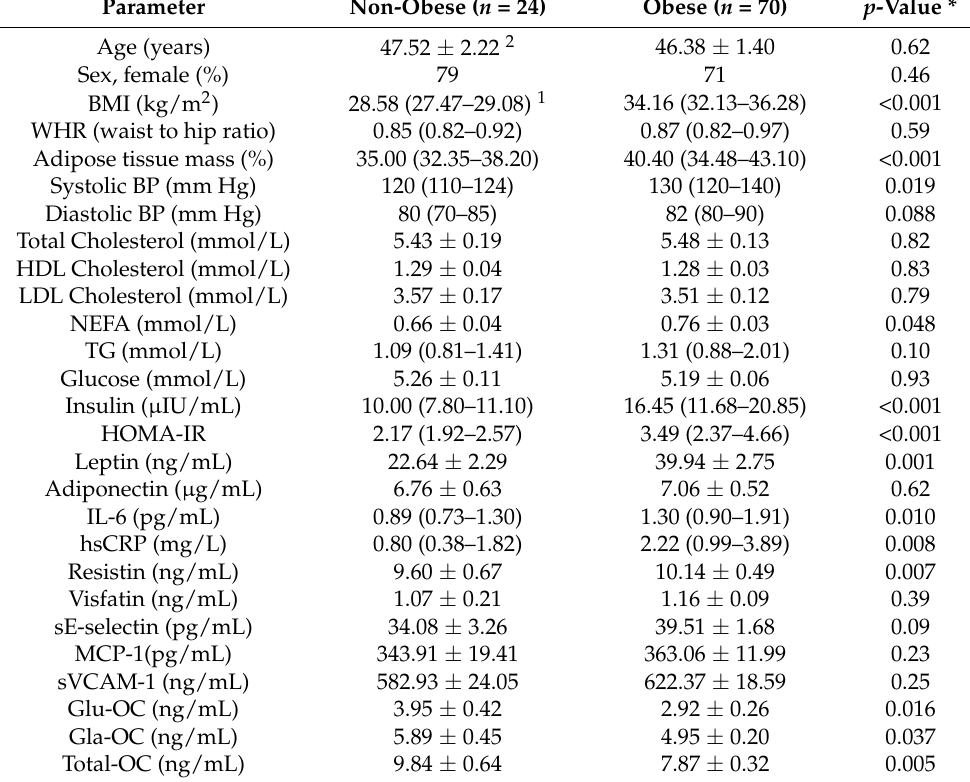
Table 2. Comparison of anthropometric and biochemical parameters between non-obese and obese